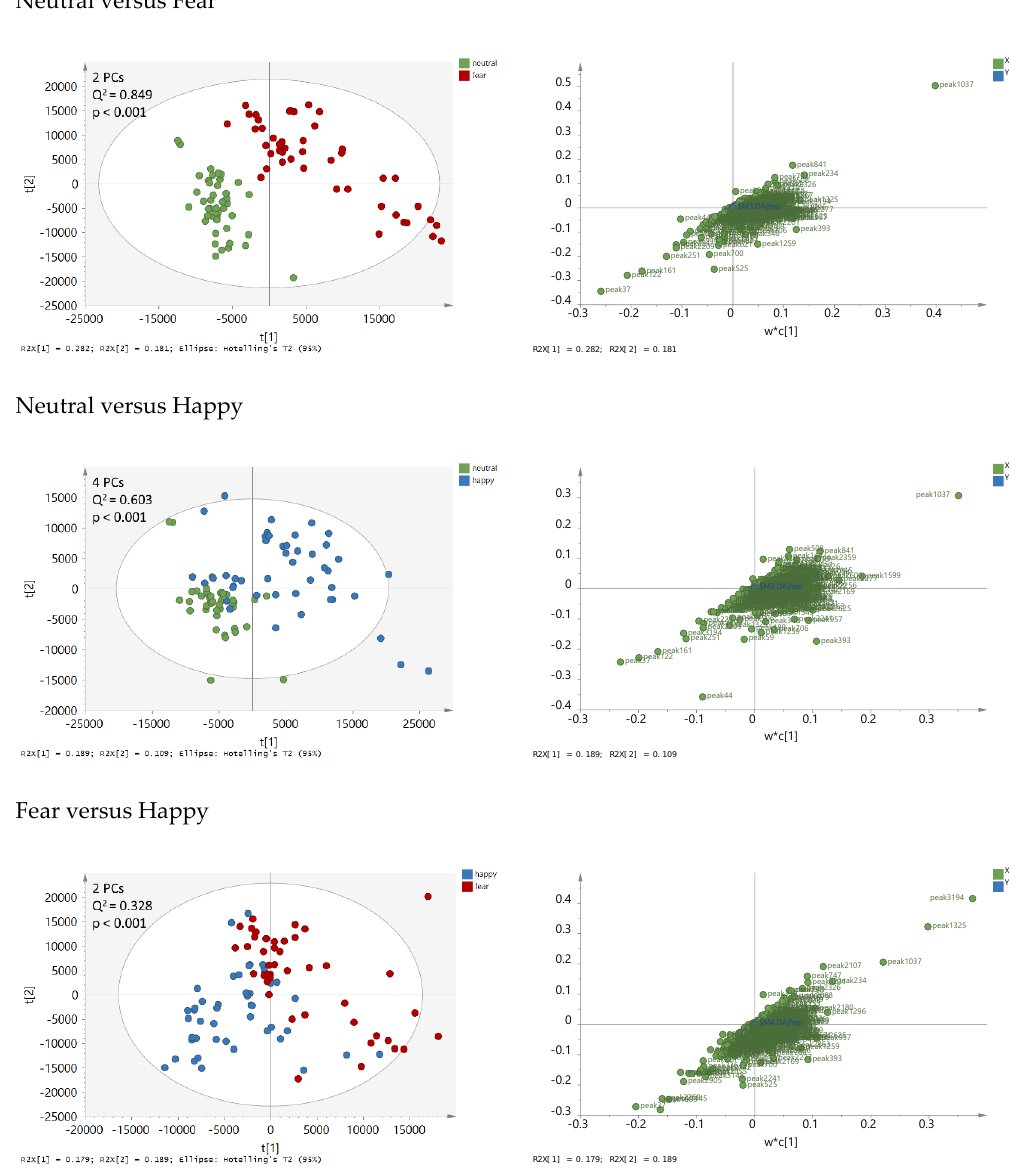
Figure 2. Partial least squares discriminant analysis (PLS-DA) score plots (left panels) and loading plots (right panels) based on 1655 peak areas and on two condition classes at a time: Neutral versus Fear (upper panels), Neutral versus Happy (middle panels), Fear versus Happy (lower panel). The first two principal components (PCs) t[1] and t[2] are displayed. The loading plots show weighted coefficients of the principal components. The data were not normalized and Pareto-scaled prior to analysis. Q 2 values > 0.2 were statistically significant.